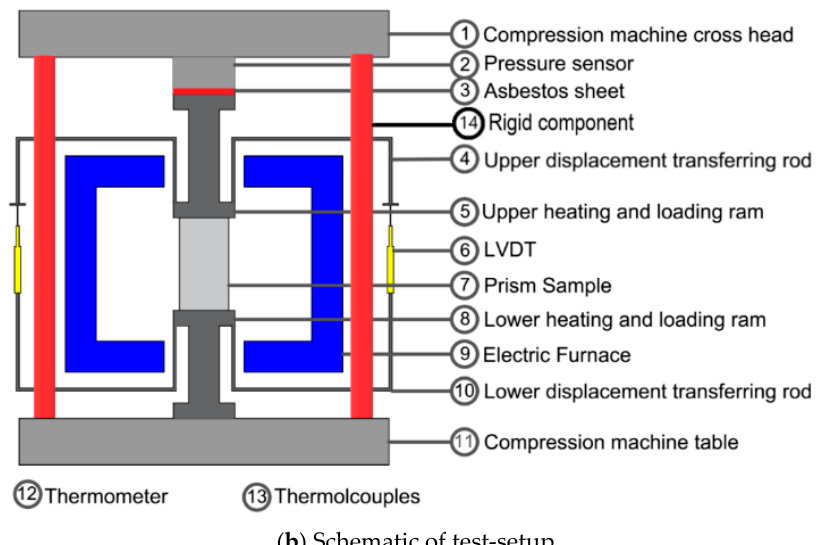
Figure 1. Experimental apparatus used in the study.